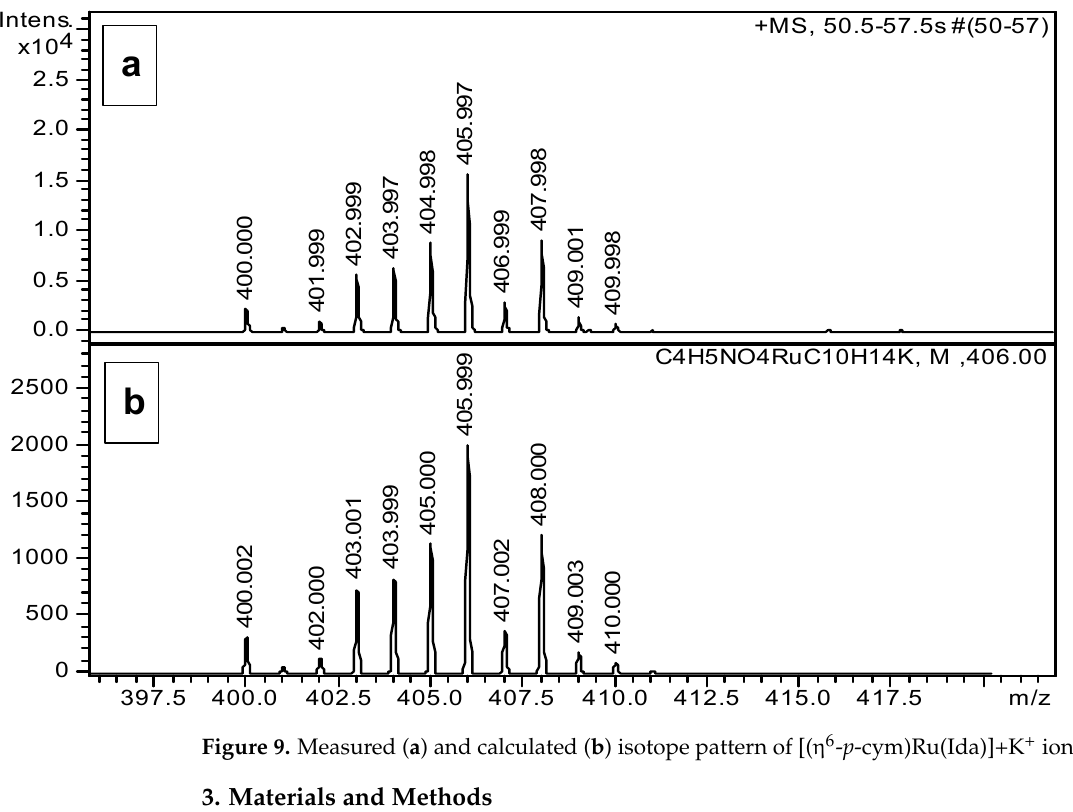
pH = 9.0 (c Ru = 0.1 mM).